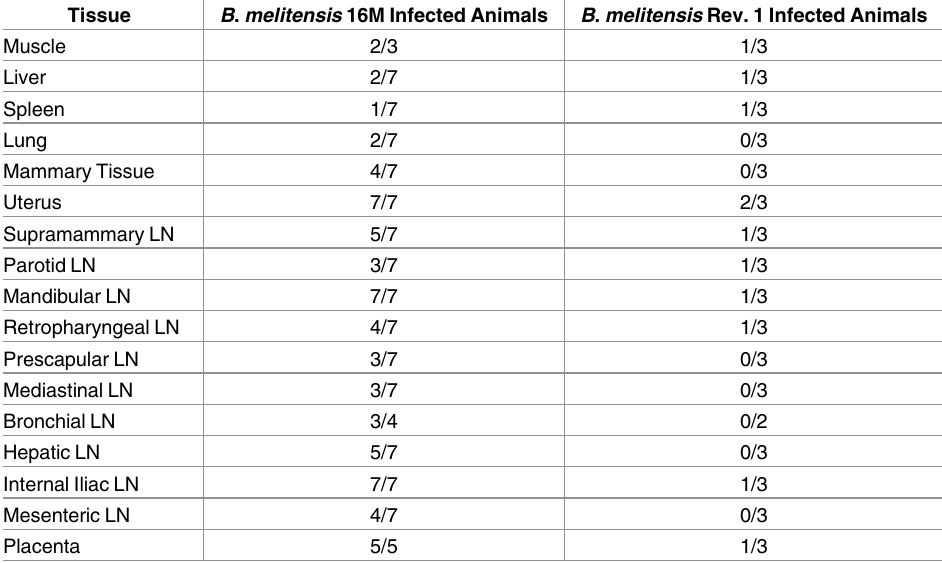
Table 2. Rate of isolation of B . melitensis 16M and Rev. 1 from tissues of pregnant does at necropsy.